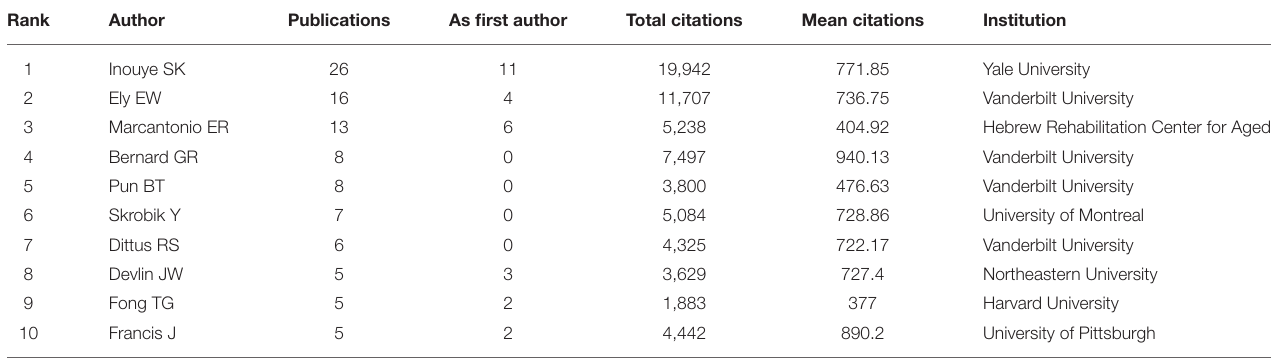
TABLE 2 | Authors with top-10 number of papers included in the top-100 articles.